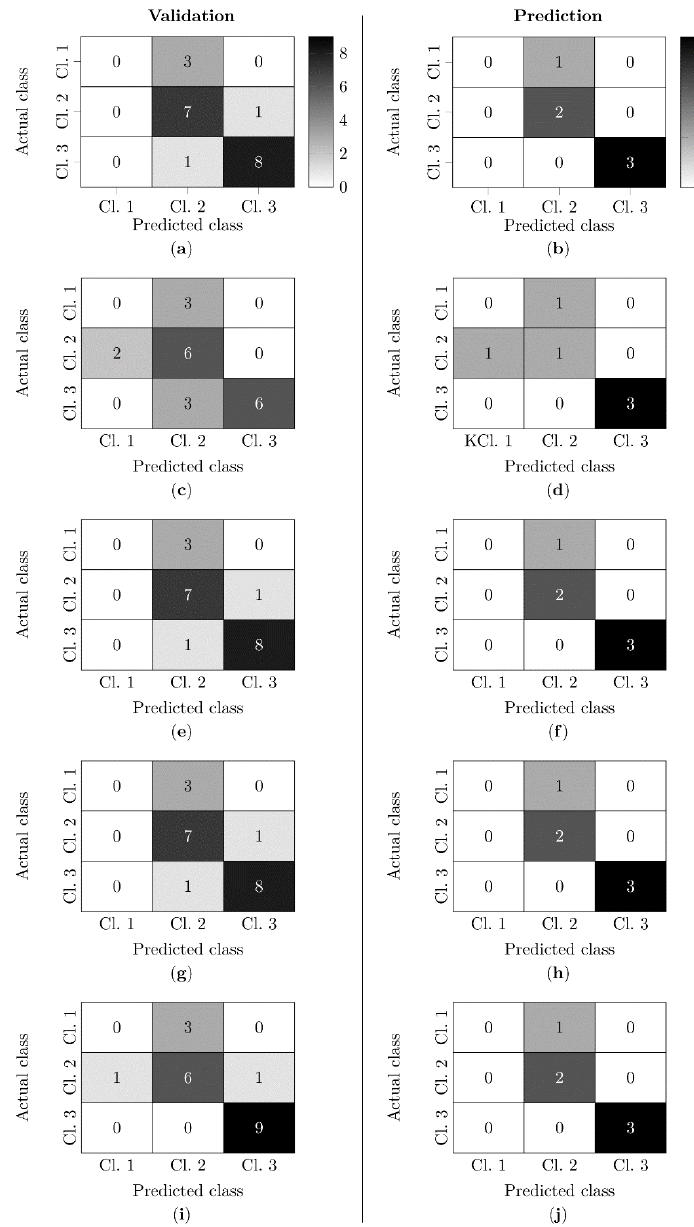
Figure 6. Confusion matrices for the classification of kidneys into three classes. Results of the classifiers for validation/prediction: support vector machine (SVM) ( a , b ), random forest (RF) ( c , d ), k-nearest-neighbor (kNN) ( e , f ), logistic regression (LOG) ( g , h ), naive bayes (BAY) ( i , j ).